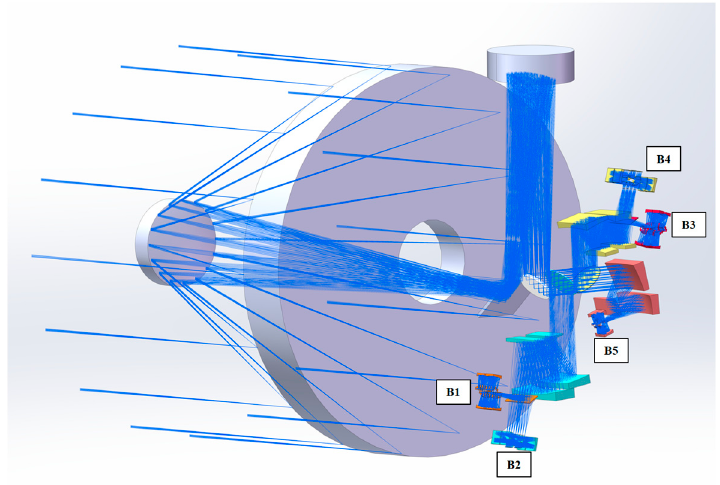
Figure 10. Optical path diagram of GeoFWHIS.